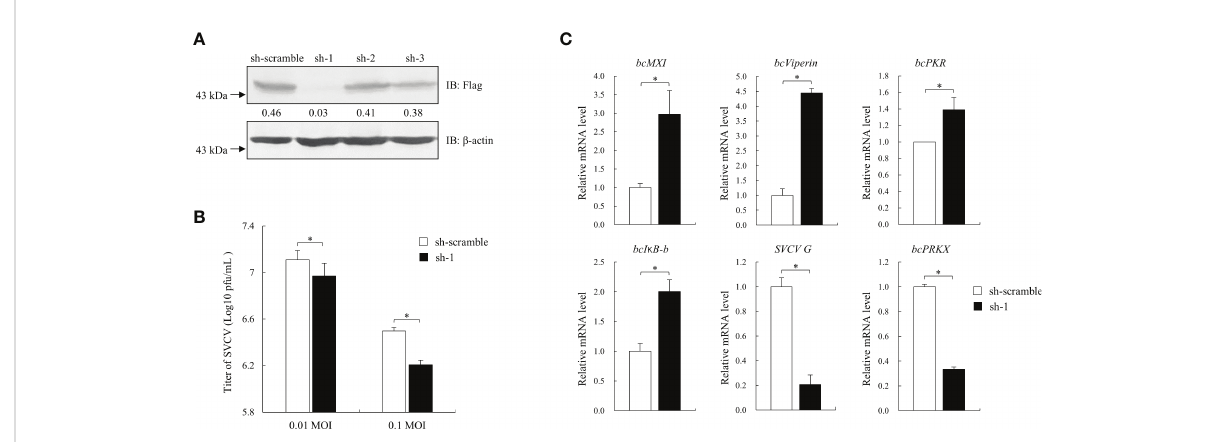
FIGURE 6 Knock-down of bcPRKX enhanced the cells ’ resistance against SVCV. (A) HEK 293T cells in a 6-well plate were co-transfected with Flag-bcPRKX and pLKO.1-sh-bcPRKX-1/2/3 (Table 1) (or pLKO.1-sh-scramble) respectively. The cells were lysed for immunoblotting at 24 h post-transfection. The numbers represented the densities of bcPRKX bands (normalized to b -actin bands). (B, C) MPK cells in a 6-well plate were transfected with pLKO.1-sh-scramble or pLKO.1-sh-bcPRKX-1 and the cells were infected with SVCV at 24 h post-transfection. The media of the cells were harvested for the viral titration at 48 h post-transfection and the cells were used for RNA isolation and qPCR analysis. Asterisk (*) stands for statistical difference (p<0.05)